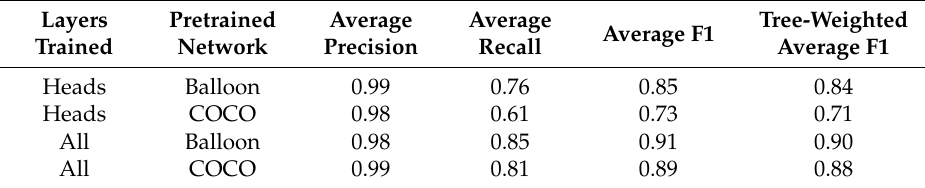
Figure 3. Average F1 score for each training epoch for instances of Mask R-CNN initialized with the Balloon and COCO pretrained networks. Average F1 scores for training epochs where only the network heads were adjusted are displayed in ( a ). Average F1 scores for training epochs where all layers of Mask R-CNN were adjusted are displayed in ( b ). Table 3. Average precision, recall, and F1 score values for instances of Mask R-CNN trained under different parameters. Column 1 lists the network layers adjusted during training and Column 2 lists the pretrained network with which training was initialized. The average F1 score as weighted by the number of total trees is also included for reference.